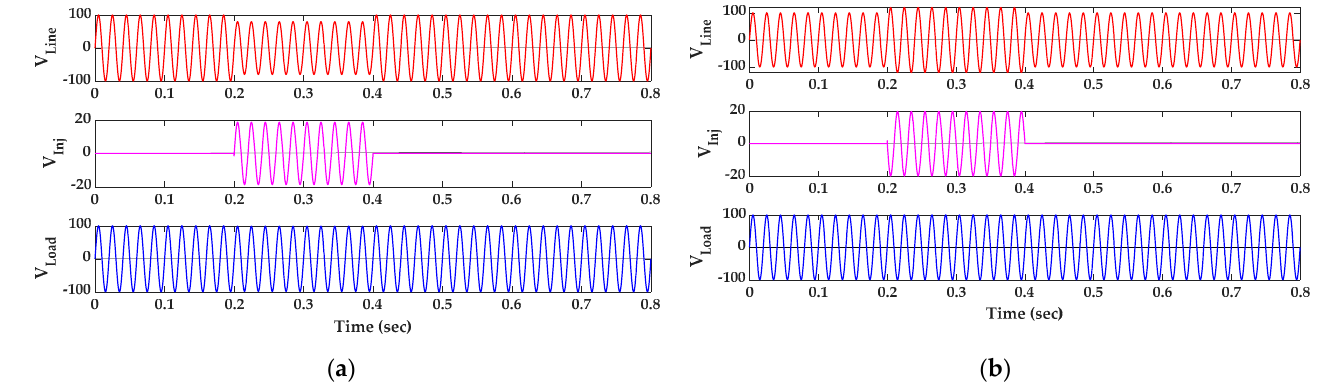
Figure 11. Grid voltage compensation during the problem of ( a ) voltage sag and ( b ) voltage swell.